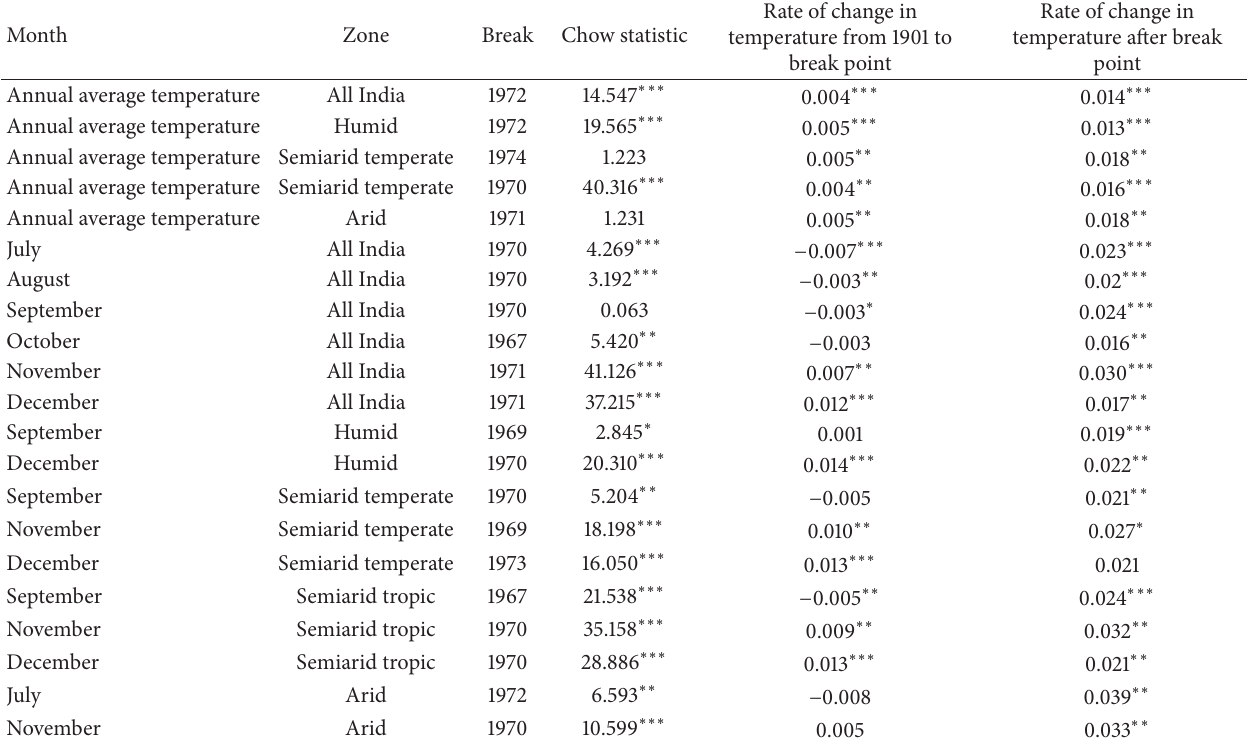
Table 2: Structural break point alongwith their significance level by Chow